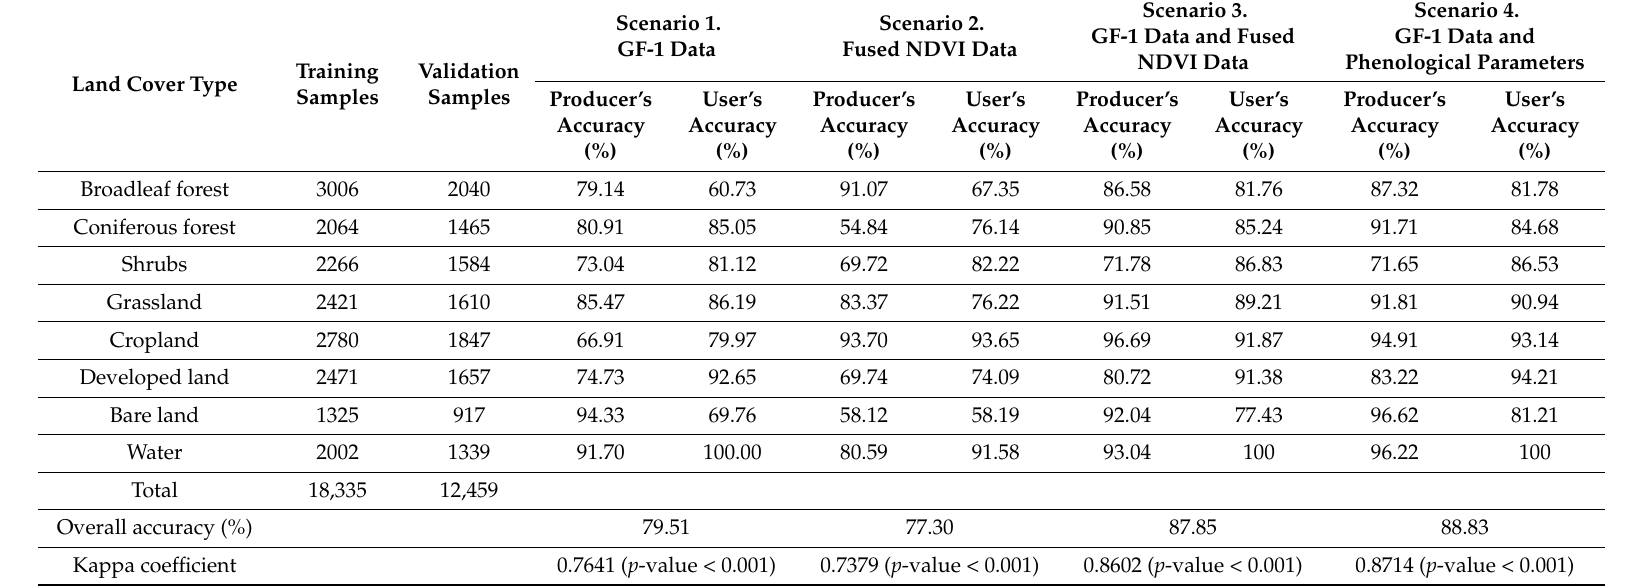
Table 6. Number of pixels in the training and validation samples for each land cover type and Comparison of classification accuracies based on the different scenarios.